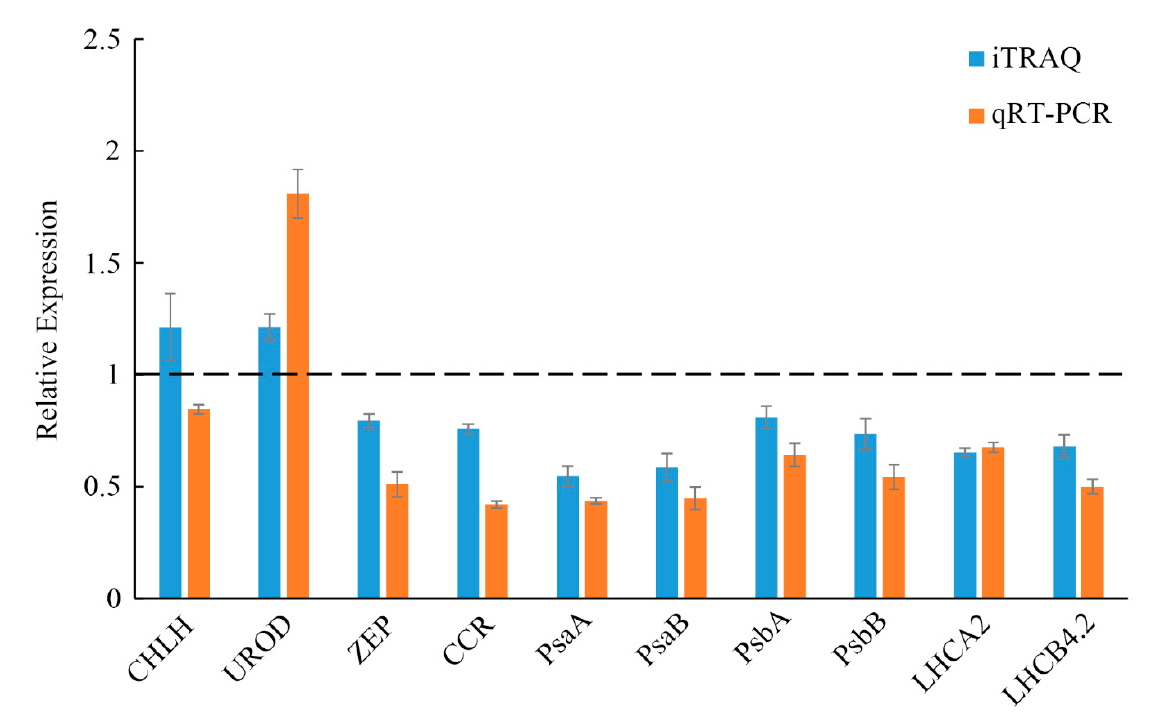
Figure 8. Comparison of levels of RNA and protein of differentially accumulated proteins via qRT- PCR and iTRAQ. Green leaf data was set to 1.0. Displayed values in mutant leaves are means ± SD ( n = 3). CHLH: magnesium chelatase H; UROD: uroporphyrinogen decarboxylase; ZEP: zeaxanthin epoxidase; CCR: cinnamoyl-CoA reductase; PsaA: photosystem I P700 chlorophyll a apoprotein A1; PsaB: photosystem I P700 chlorophyll a apoprotein A2; PsbA: photosystem II protein D1; PsbB: pho-